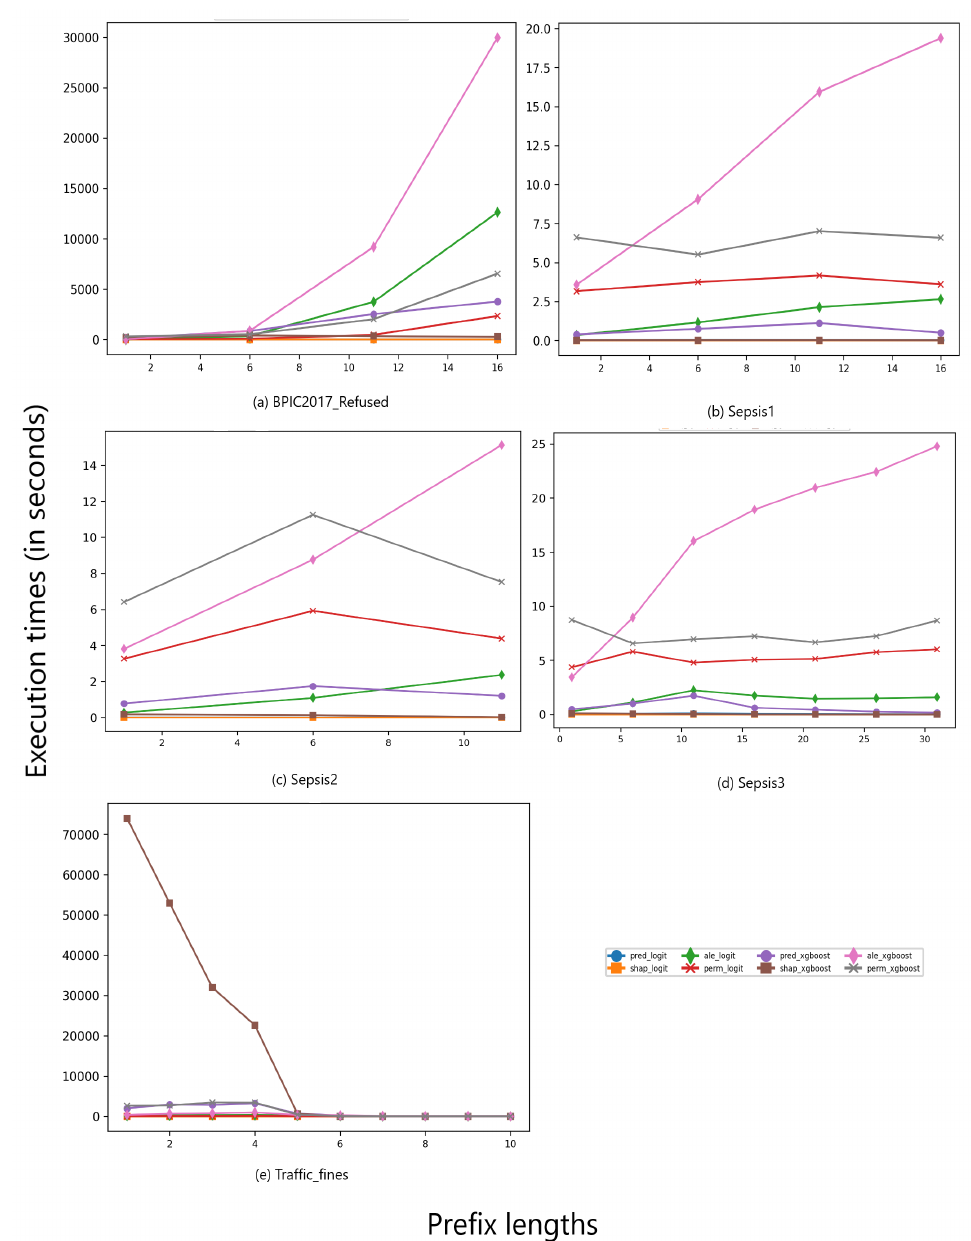
Figure A1. Execution times (in seconds) of XAI methods on event logs preprocessed using prefix index